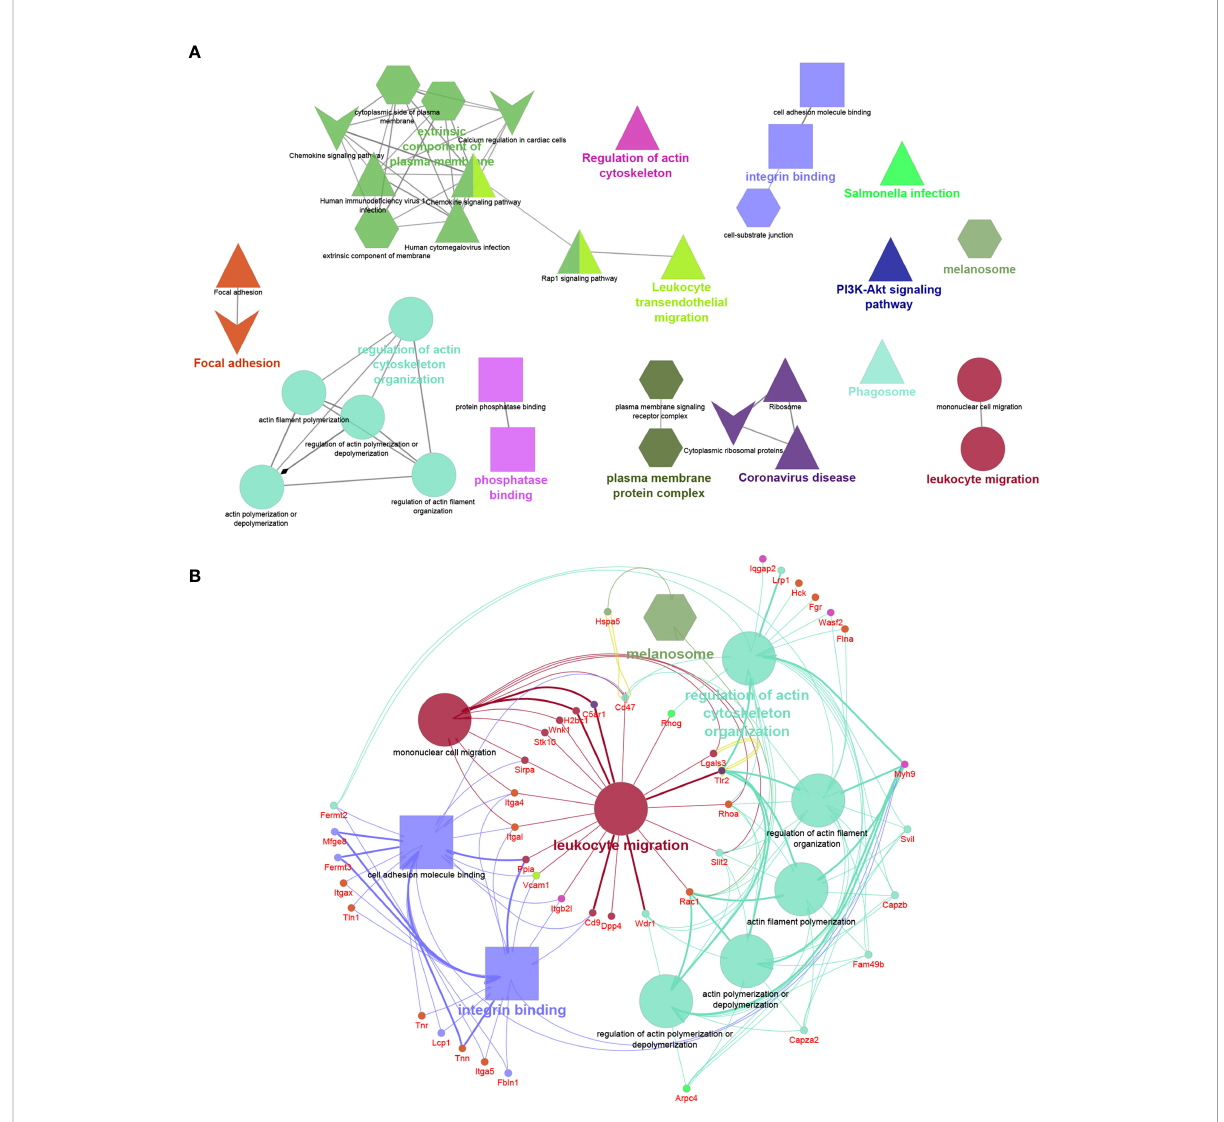
FIGURE 6 (A) Network created with the proteins unique to F5-10 Cd38 -/- EV. (B) Network showing the major functional terms and associated genes unique to F5-10 Cd38 -/- EV. The network has been created using the ClueGO and Cluepedia applications of Cytoscape, with the GO Biological Process (circles), GO Cellular Component (hexagons), GO Molecular Function (rectangles), KEGG (triangles), and Wiki Pathways (V shape); pV < 0.05. Terms are functionally grouped based on shared proteins (kappa score) and each functional group is shown with a different color. The term with the highest statistical signi fi cance within each functional group is highlighted in bold. The size of the nodes indicates the degree of signi fi cance. The most signi fi cant term de fi nes the name of the